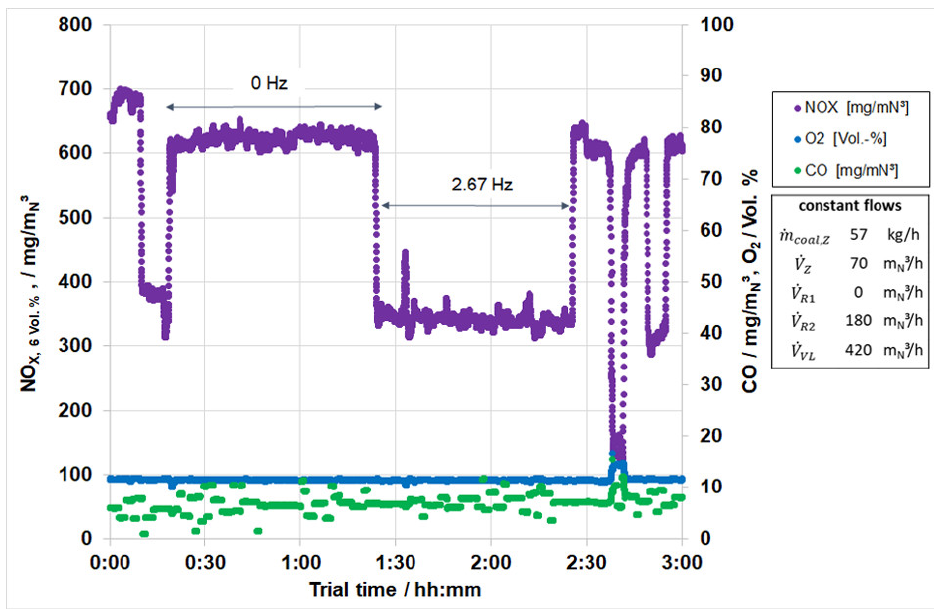
Figure 13. Oscillation of a high-volume air flow in R2 at 2.67 Hz. The reduction in NO X emissions due to oscillation of the volume flow in R2 at 2.67 Hz is clearly visible. For the two experiments a constant nitrogen oxide concentration of 620 mg/m N3 for the oscillation-free and 350 mg/m N3 for the oscillating process control is achieved over the 60-min test period. Accordingly, the nitrogen oxides in the flue gas are reduced by